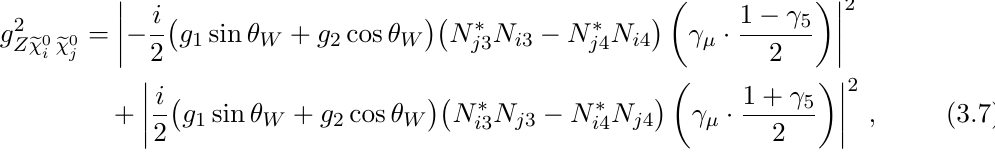
(cid:31) 0 - (cid:31) 0 mass di(cid:11)erence. In panels (c) and e e 1 2